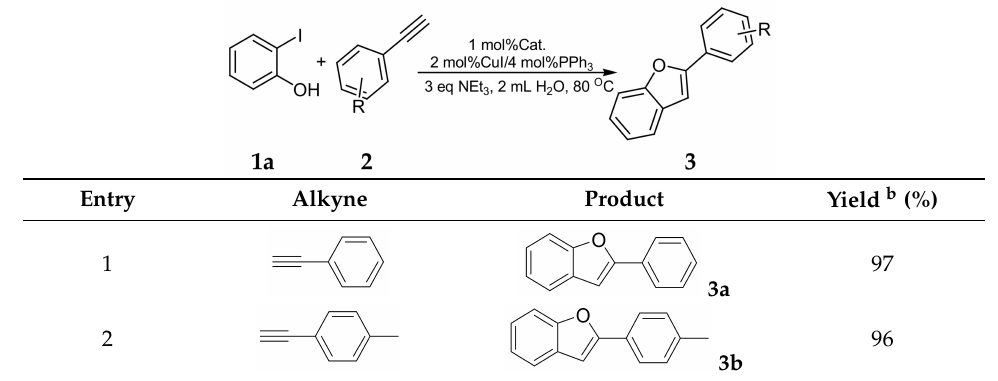
Table 2. Scope of the reaction with respect to aromatic acetylenes a